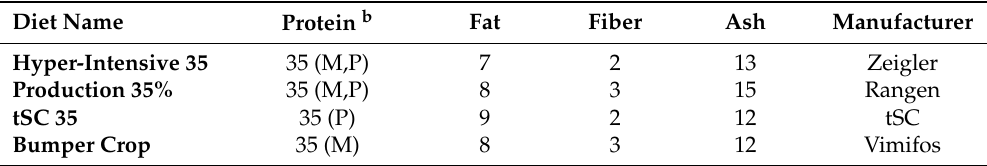
Table 2. Partial nutrient content of aquaculture diets a . Values are expressed as percentage